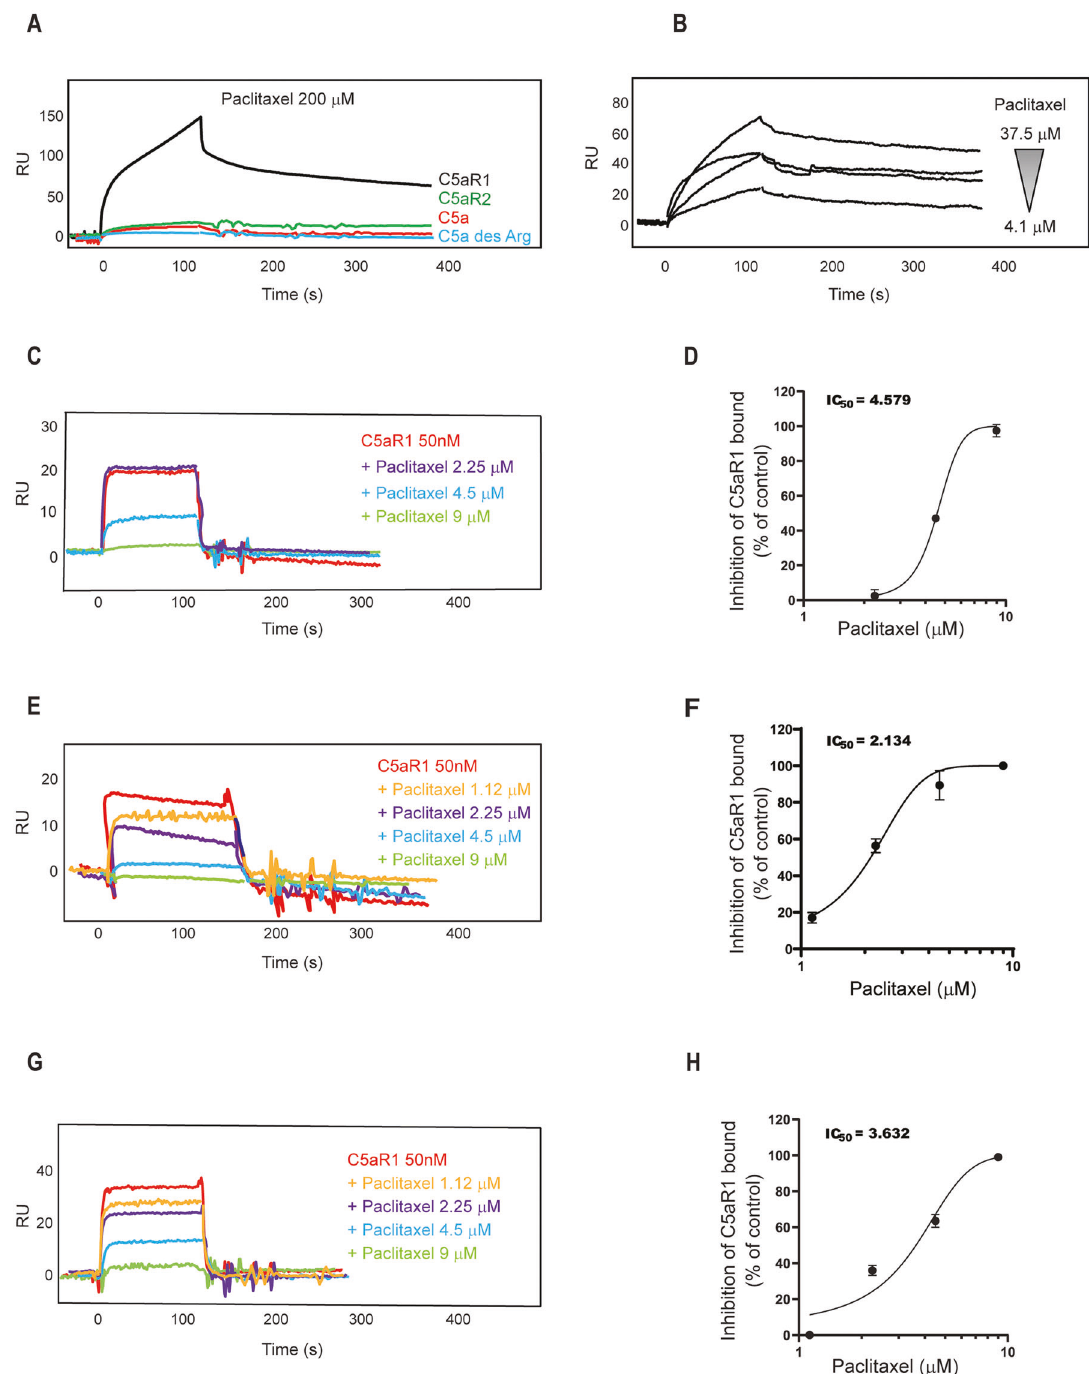
Fig. 2 Paclitaxel and C5aR1 binding studies by SPR. ( A ) Binding of paclitaxel on immobilized C5aR1, C5aR2, C5a, and C5a des-Arg. ( B ) Dose- dependent binding of paclitaxel on immobilized C5aR1. ( C , D ) Co-injection of paclitaxel and C5aR1 on immobilized C5a and relative IC50. ( E , F ) Co-injection of paclitaxel and C5aR1 on immobilized C5a des-Arg and relative IC50. G , H Co-injection of paclitaxel and C5aR1 on immobilized monoclonal antibody anti-C5aR1 and relative IC50. (Fig. 7). In paclitaxel- and C5a-treated RAW 264.7, the levels of We performed the pro fi ling of cytokines released (>40 cytokines) monocyte chemoattractant protein-1 (MCP-1), which is a chemo- from M0 (differentiated, not stimulated) RAW 264.7 and human kine involved in basophil migration and anaphylaxis [27], resulted macrophages challenged with paclitaxel (10 nM) or C5a (10 nM) signi fi cantly increased compared to the control group, as well as for 24 h using a proteome pro fi ler assay. Upon both treatments, those of macrophage in fl ammatory protein (MIP)-1 α and MIP-1 β , murine and human proteome pro fi les resembled that of typical and of MIP-2 and IL1Ra (Fig. 7A, B). The release of these cytokines anaphylaxis and overlapped for all cytokines analyzed, excluding was counteracted by C5aR1 inhibition mediated by Avacopan C5a that was released only by C5a-stimulated cells, as expected